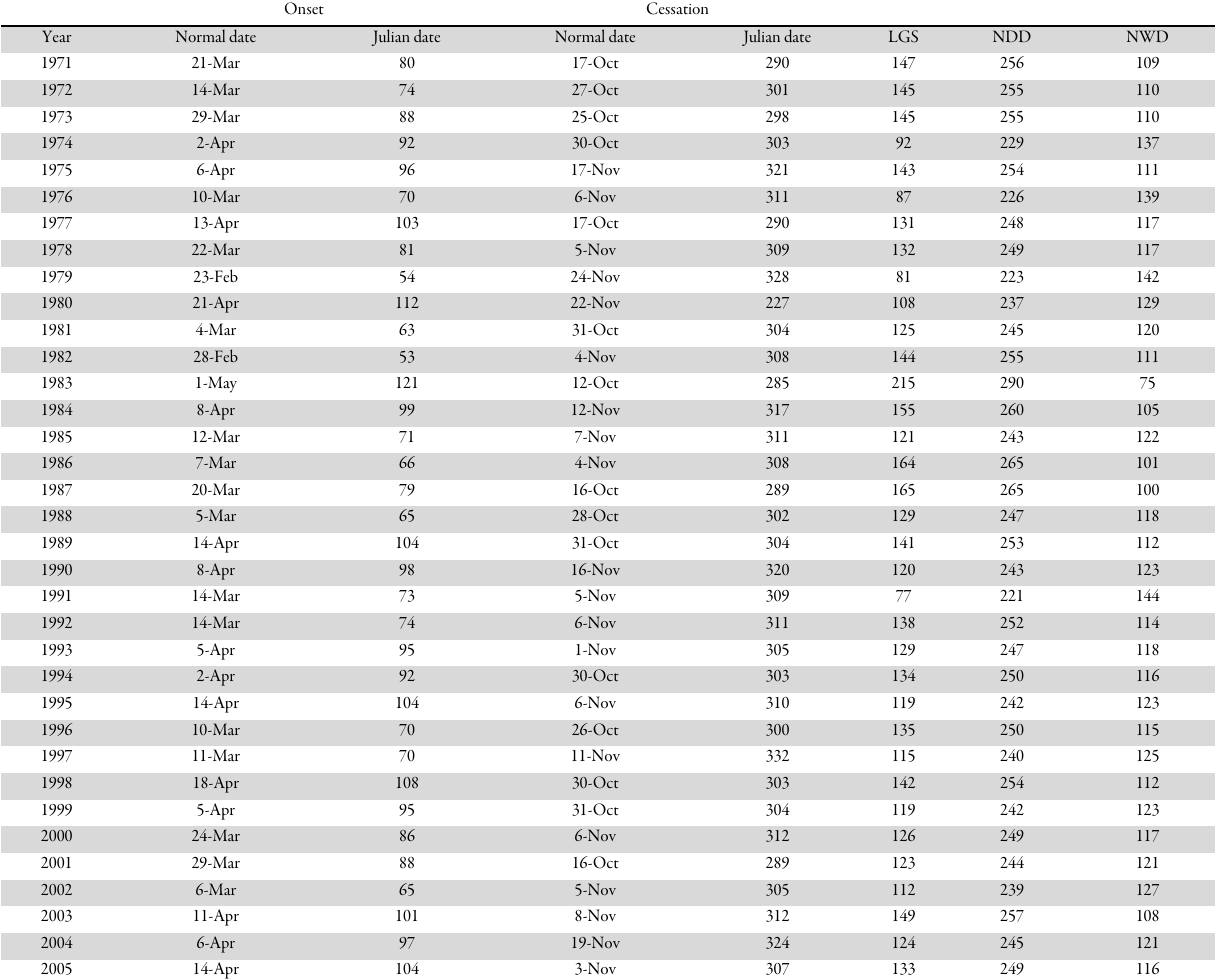
Table 1. Onset, cessation, length of growing season (LGS), number of dry days (NDD) and number of wet days (NWD) in Enugu Onset